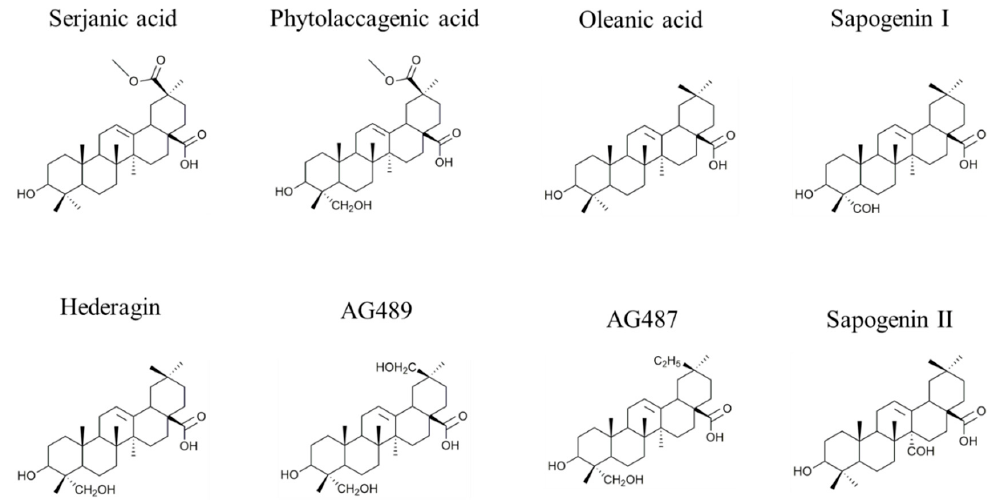
Figure 3. General structures of the sapogenins detected in Chenopodium quinoa extract in previous reports [6,28].